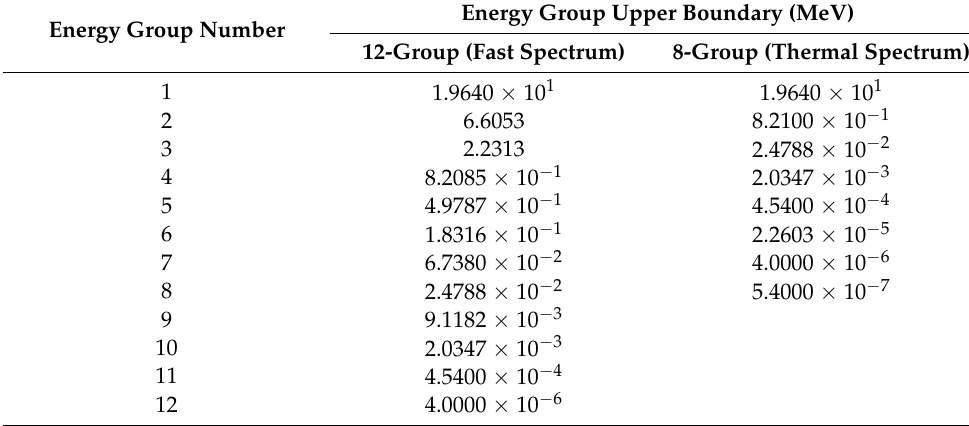
Table 3. Energy group division of the fast/thermal spectra.